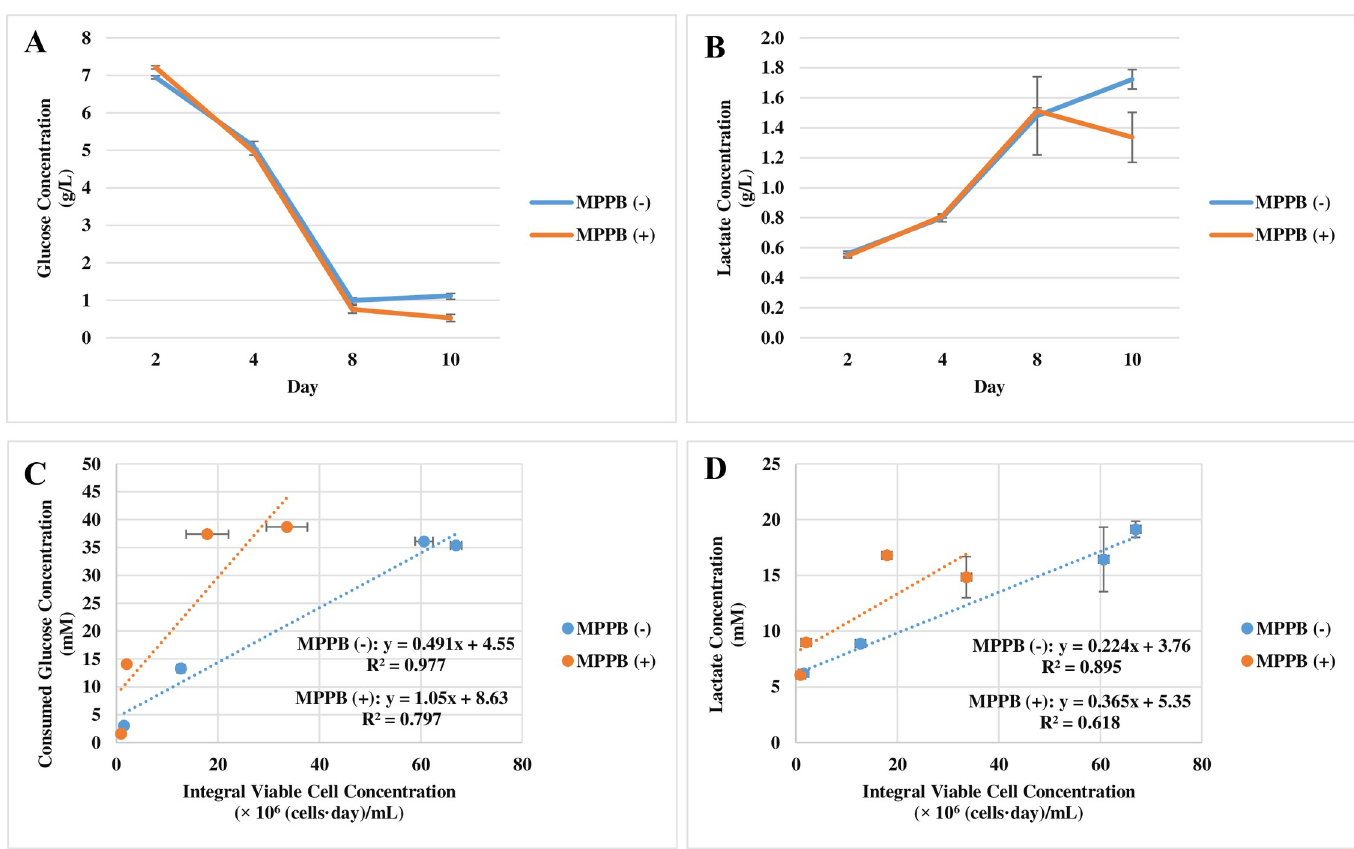
Fig 8. The effect of MPPB on the metabolite profile in the batch cultures. The spent media analysis of glucose concentration ( A ) and lactate concentration ( B ) was conducted every 2 days starting on day 2. Cell-specific glucose uptake rates ( C ) and cell-specific lactate production rates ( D ) were indicated as the slopes of consumed glucose concentration and lactate concentration, respectively to integral viable cell concentration [28,